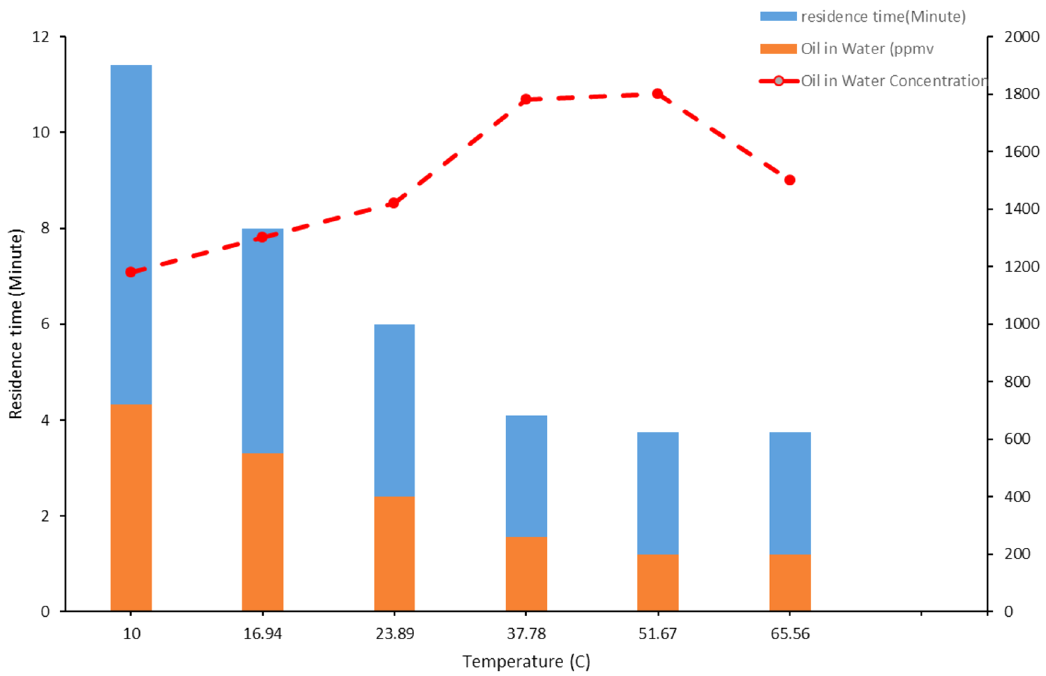
Fig. 9 Effect of temperature on separator size